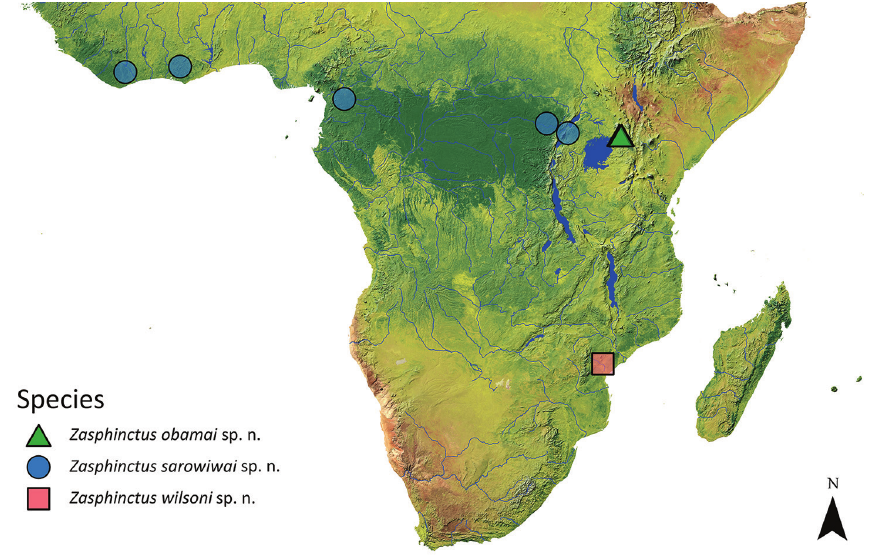
Figure 3. Map of sub-Saharan Africa showing the known distribution of the Z. obamai sp. n., Z. sarowiwai sp. n., and Z. wilsoni sp. n.